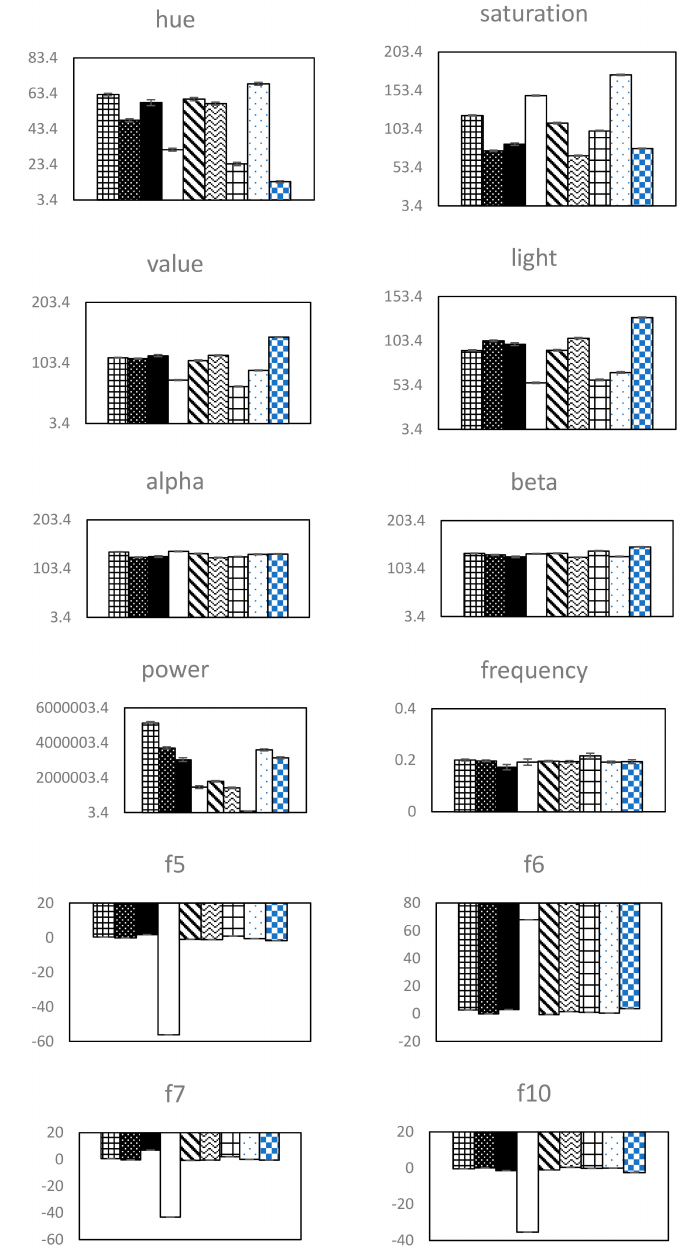
Figure 4. The mean error of the eigenvalues for gray, red, green, blue, hue, saturation, value, light, alpha, beta, power, frequency, f2, f4, f5, f6, f7, and f10 for the di ff erence between each emotion comparison. The emotional order of the bars in each plot is negative arousal, arousal, positive arousal, negative, neutral, positive, negative relaxed, relaxed, and positive relaxed from left to